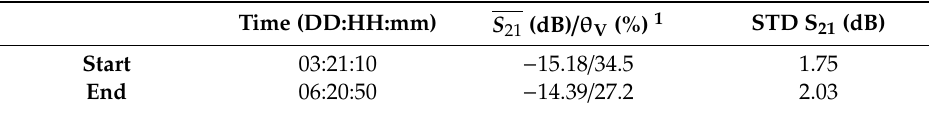
Table 4. Values obtained from specific region of Figure